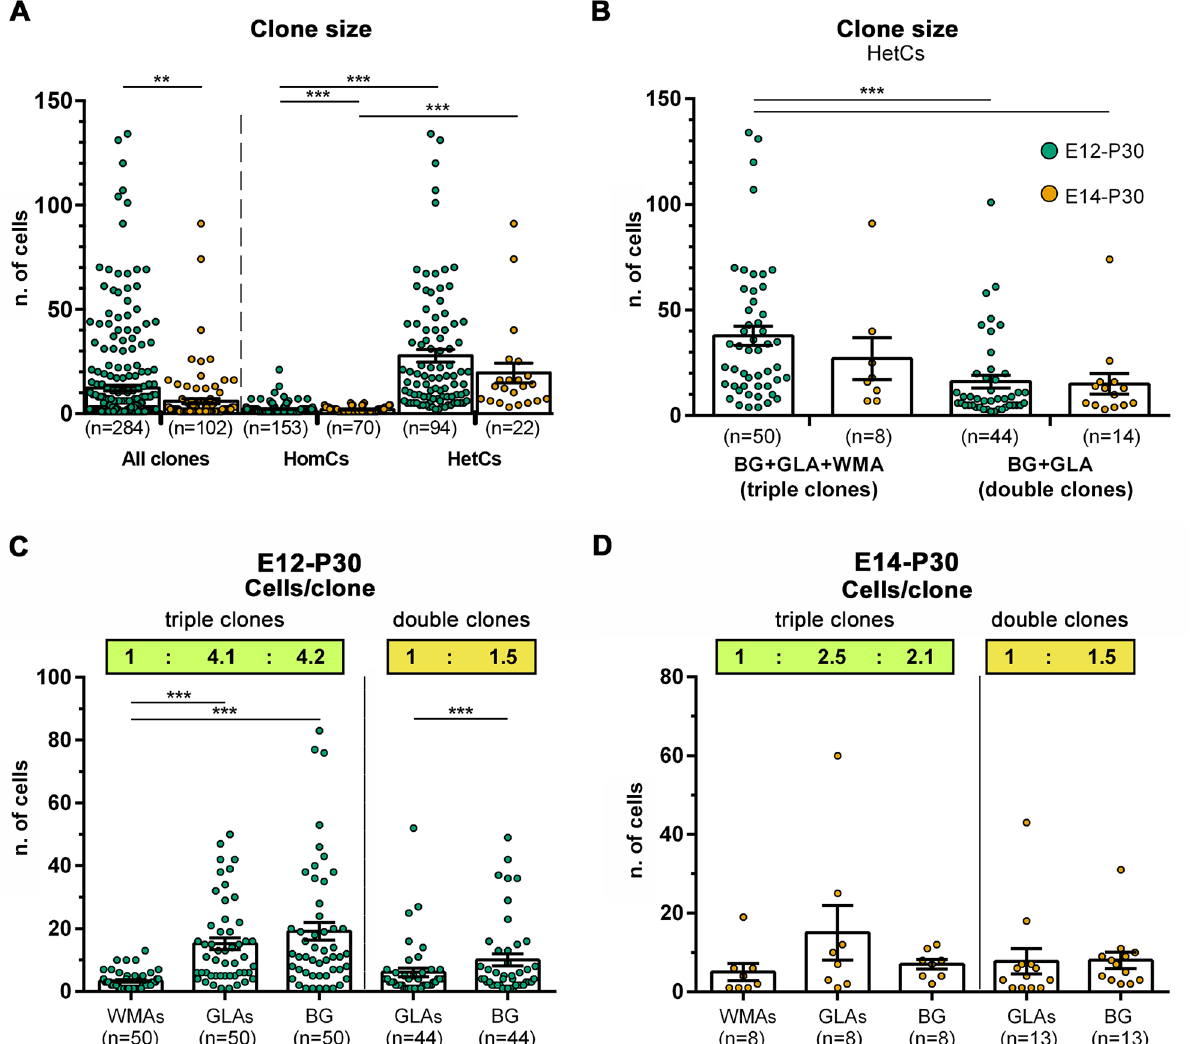
Fig 3. Quantitative analyses of clone size and stoichiometry of clone composition. (A,B) Scatterplots of clone size. (A) E12-P30 clones (green) are overall bigger than E14-P30 clones (orange). This same trend is maintained when comparing HomCs and HetCs within each time point ( P < 0.001). E12-P30 HomCs contain more cells compared to E14-P30 clones, whereas HetCs’ size changes do not reach statistical significance ( P = 0.081). (B) Triple BG+GLA+WMA clones are the biggest clone type and tend to be smaller when generated later ( P = 0.317). Double BG+GLA clones are smaller than triple clones and display the same average size in the 2 data sets ( P = 0.750). (C,D) Scatterplots show the number of distinct astroglial types in triple and double clones after E12 (C) or E14 (D) IUE. The insets report the clone-wise stoichiometry, rounded to the first decimal, which shows a joint expansion of GLAs and BG compared to WMAs in triple clones, whereas in double clones, BG prevail over GLAs. (cid:3)(cid:3) , P < 0.01; (cid:3)(cid:3)(cid:3) , P < 0.001; P values are calculated with GEE analysis. n = number of clones. The numerical data used in the figure are included in S1 Data. BG, Bergmann glia; E, embryonic day; GEE, generalized estimating equations; GLA, granular layer astrocyte; HetC, heterogeneous clone; HomC, homogeneous clone; IUE, in utero electroporation; WMA, white matter astrocyte.